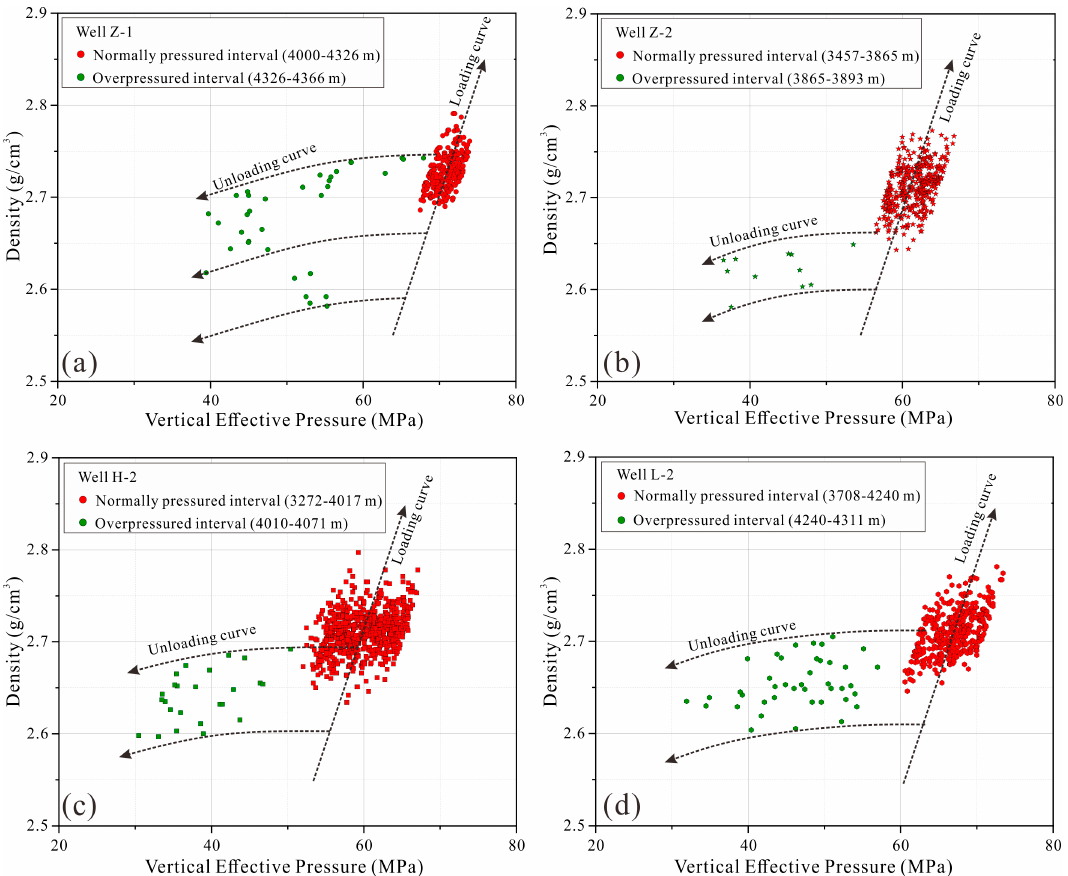
Figure 12. Vertical effective stress–density cross plots for four wells in the study area. ( a ) Well Z-1; ( b ) Well Z-2; ( c ) Well H-2; ( d ) Well L-2. The points lie on the loading curve, indicating normal compaction, or overpressure caused by disequilibrium compaction, whereas the data are on an unloading curve, suggesting overpressure resulted from hydrocarbon generation expansion.